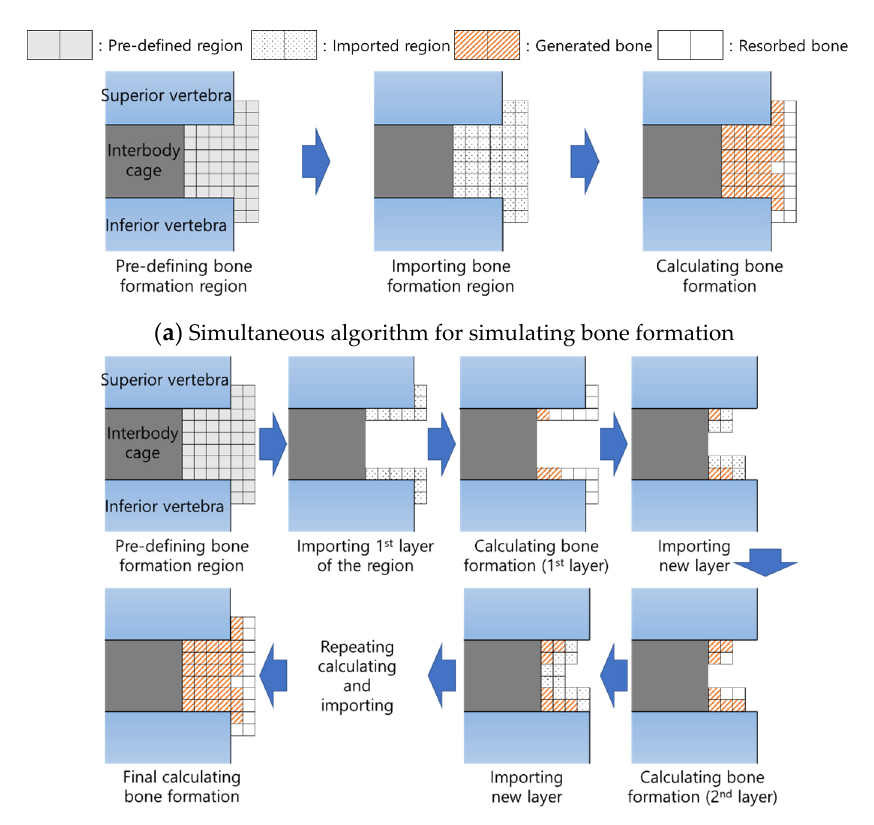
Figure 3. Schematic diagram of bone formation around an embedded interbody cage using two algorithms.